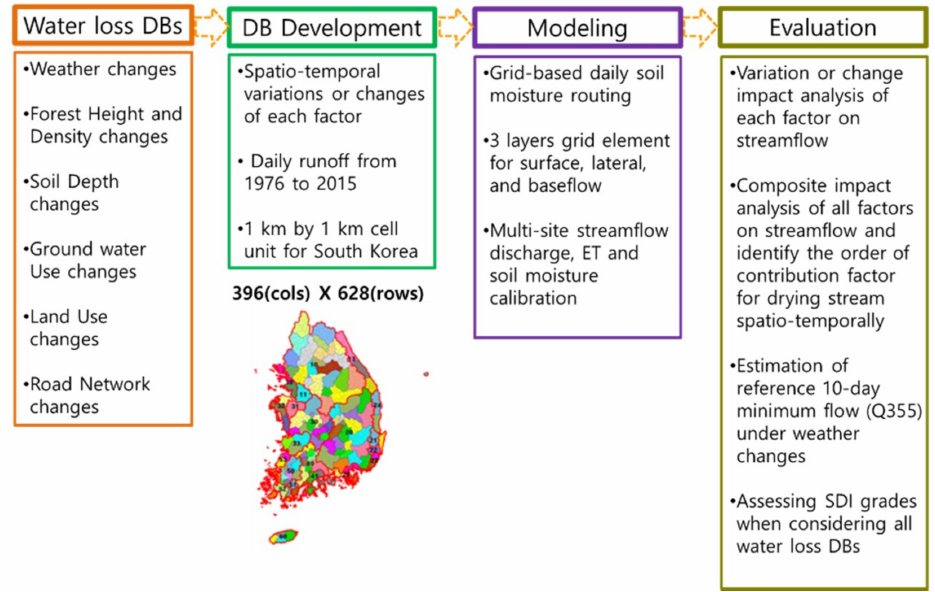
Figure 1. The model structure and flow chart in this